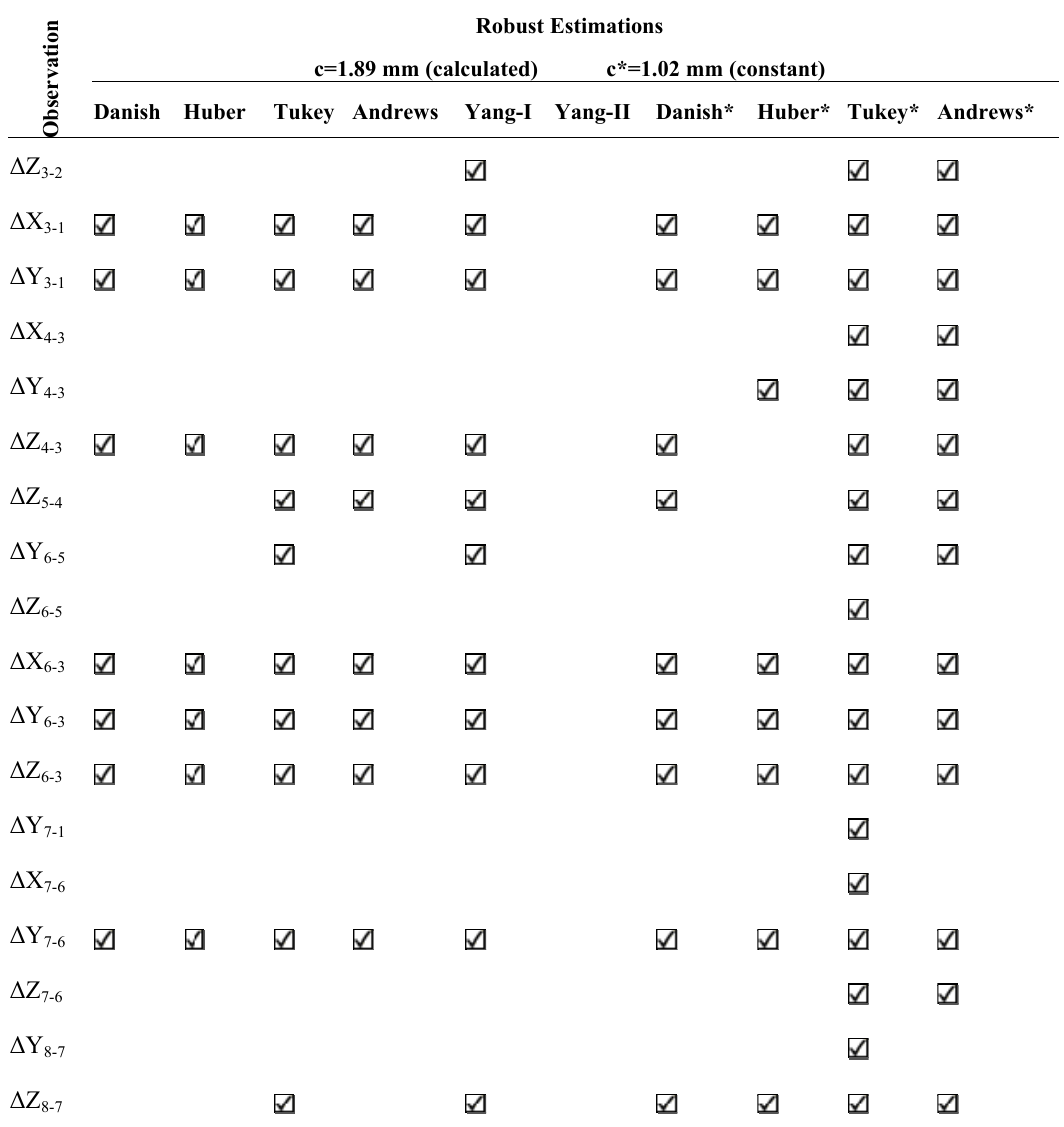
Table 7 . Results of the Robust Estimators for the First GPS